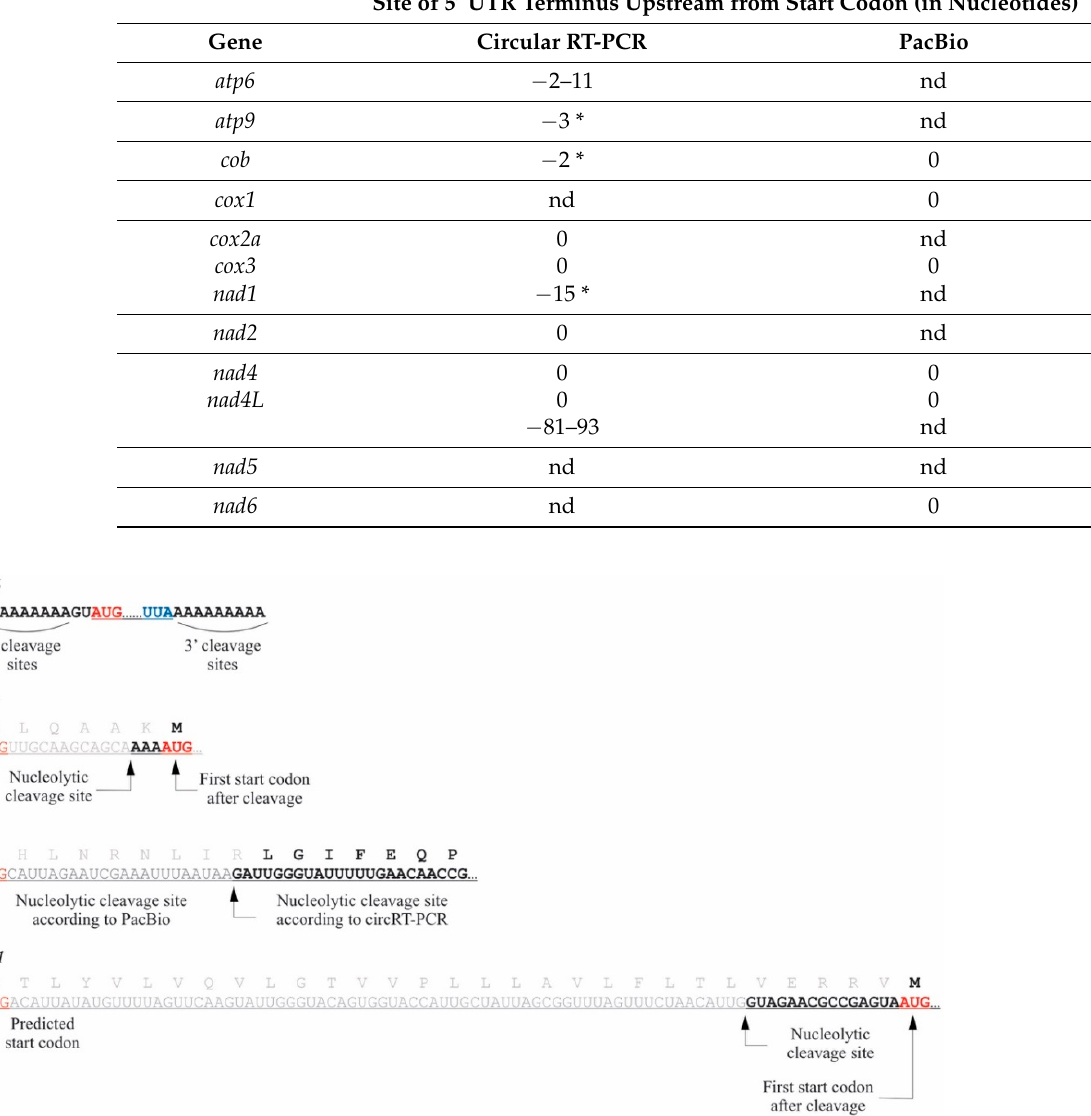
Table 1. Site of 5 ′ UTR terminus upstream from start codon (in nucleotides) in Pediastrum duplex mitochondria, nd = no data. * Some 5 ′ UTR termini detected in this study occur downstream of the start codons in archived chondriomes. The distances presented in this table are marked from the next available AUG start codon.